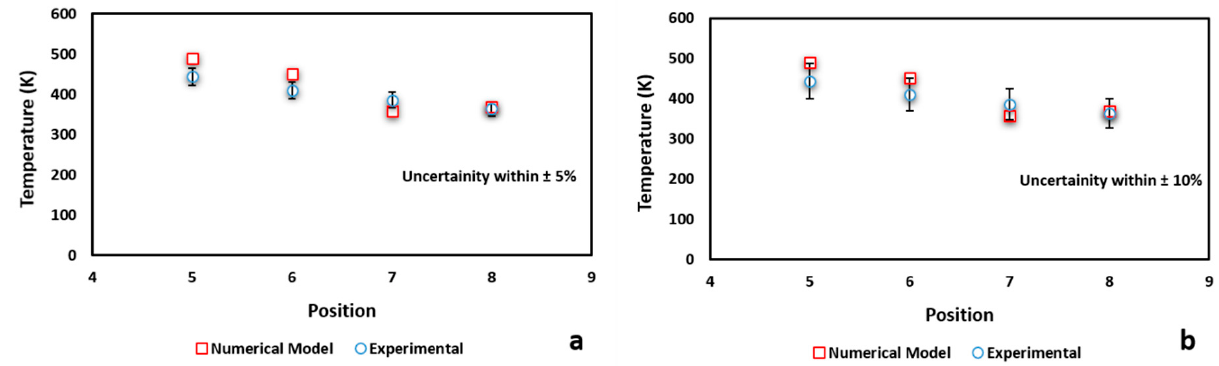
Figure 20. Temperatures measured at peephole 2 obtained using CFD model and experimental tests: ( a ) 5% uncertainty; ( b ) 10% uncertainty.